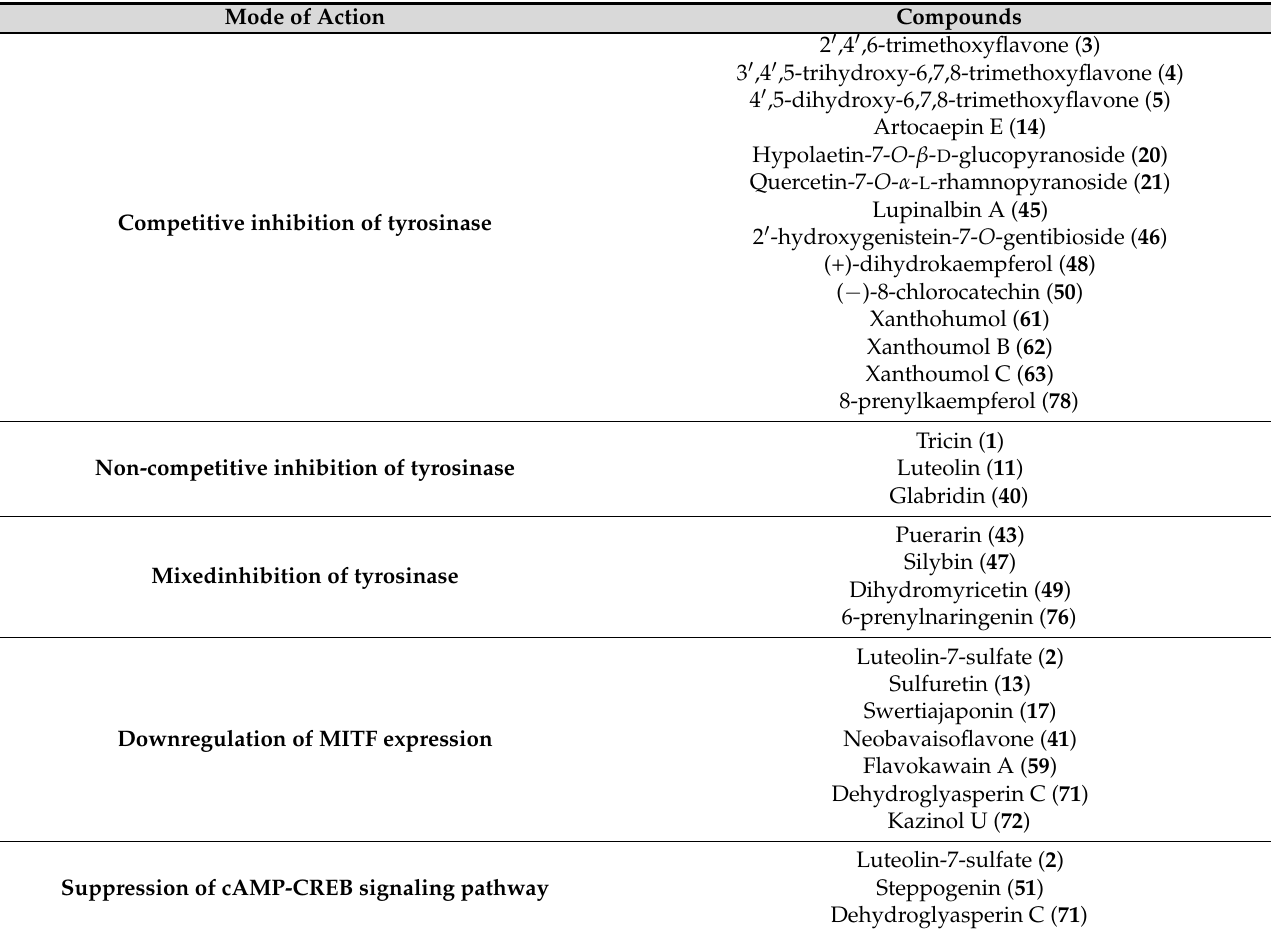
Table 2. Summarized modes of tyrosinase inhibitory actions for